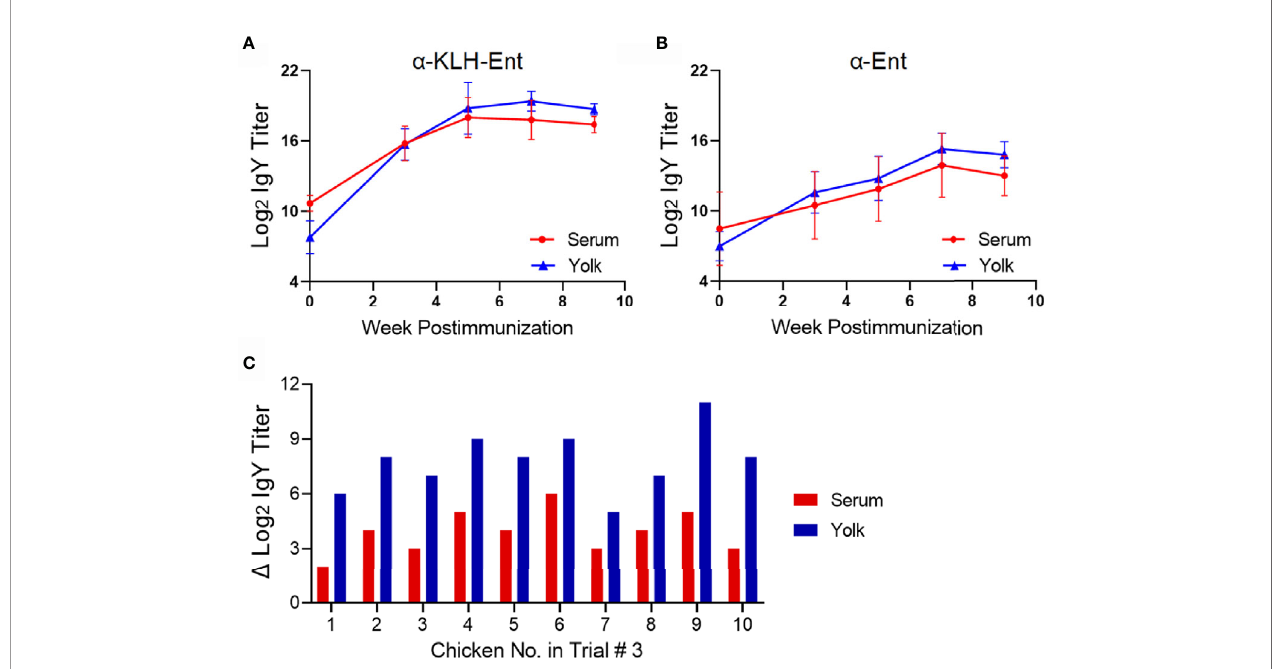
FIGURE 6 | Immune response of White Leghorn layers upon subcutaneous immunization with the KLH-Ent conjugate (Trial #3). A total of ten White Leghorn laying hens received subcutaneous injections with the KLH-Ent conjugate three times ( Figure 1A ). (A) Serum and egg yolk IgY titer against the KLH-Ent conjugate. Each point represents mean IgY titer ± standard deviation from ten layers with duplicate measurements within each chicken. (B) Serum and egg yolk IgY titer against Ent molecule. Each point represents mean IgY titer ± standard deviation from ten layers with duplicate measurements within each chicken. (C) The increase of Ent-speci fi c IgY titer in serum (red bar) and egg yolk (blue bar) in each individual chicken. Y-axis represents the increase in Log 2 transformed IgY titer from 0 week to 9 weeks